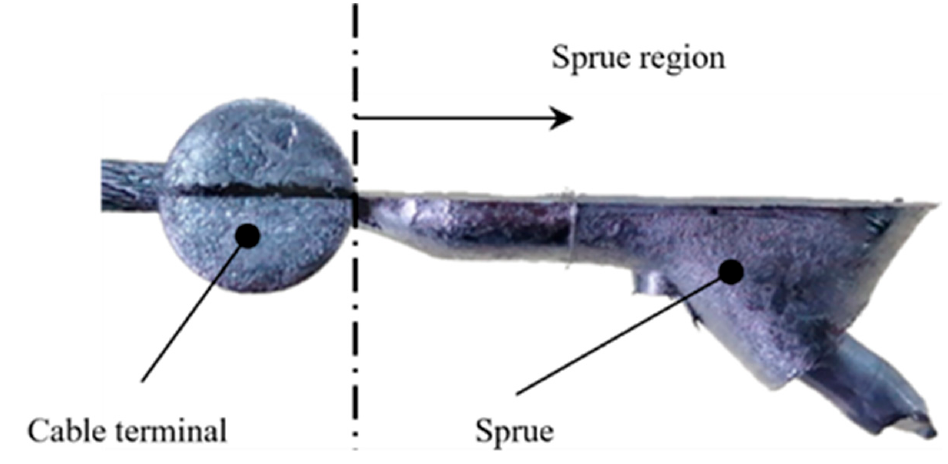
Figure 1. Cable terminal with its sprue.